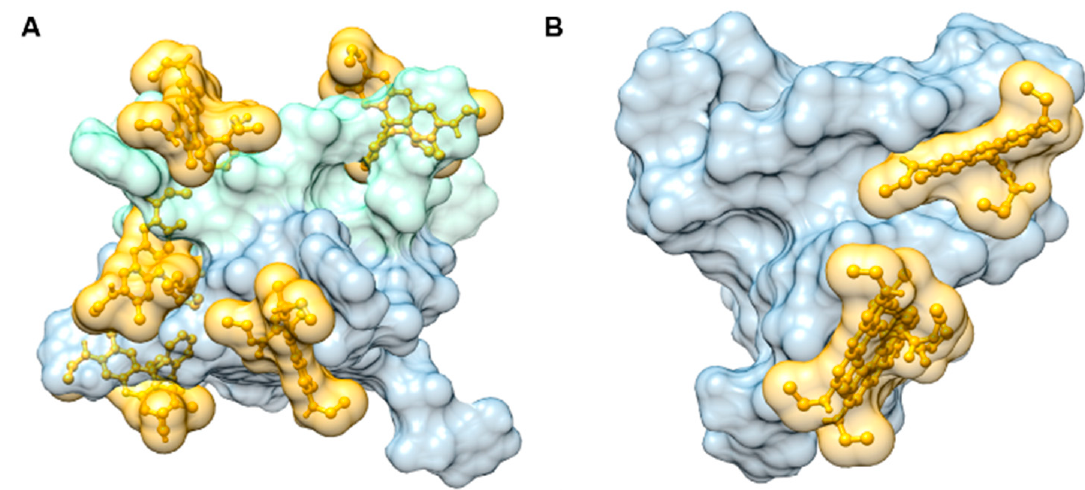
Figure 9. Putative binding of the RhG ligand within the quadruplex structure PDB 2le6 ( A ) and 2jpz ( B ) obtained from docking simulations. Only the leading structures of the most populated binding clusters are depicted. The quadruplex is drawn in a solvent-accessible surface representation. The ligand is shown in a ball and stick representation. The solvent-accessible surface of the ligand is also shown. The ligand is shown fitting into the quadruplex grooves. The subunits of 2le6 are colored with different hues, pale green and blue grey. Images were prepared using Chimera software [43].